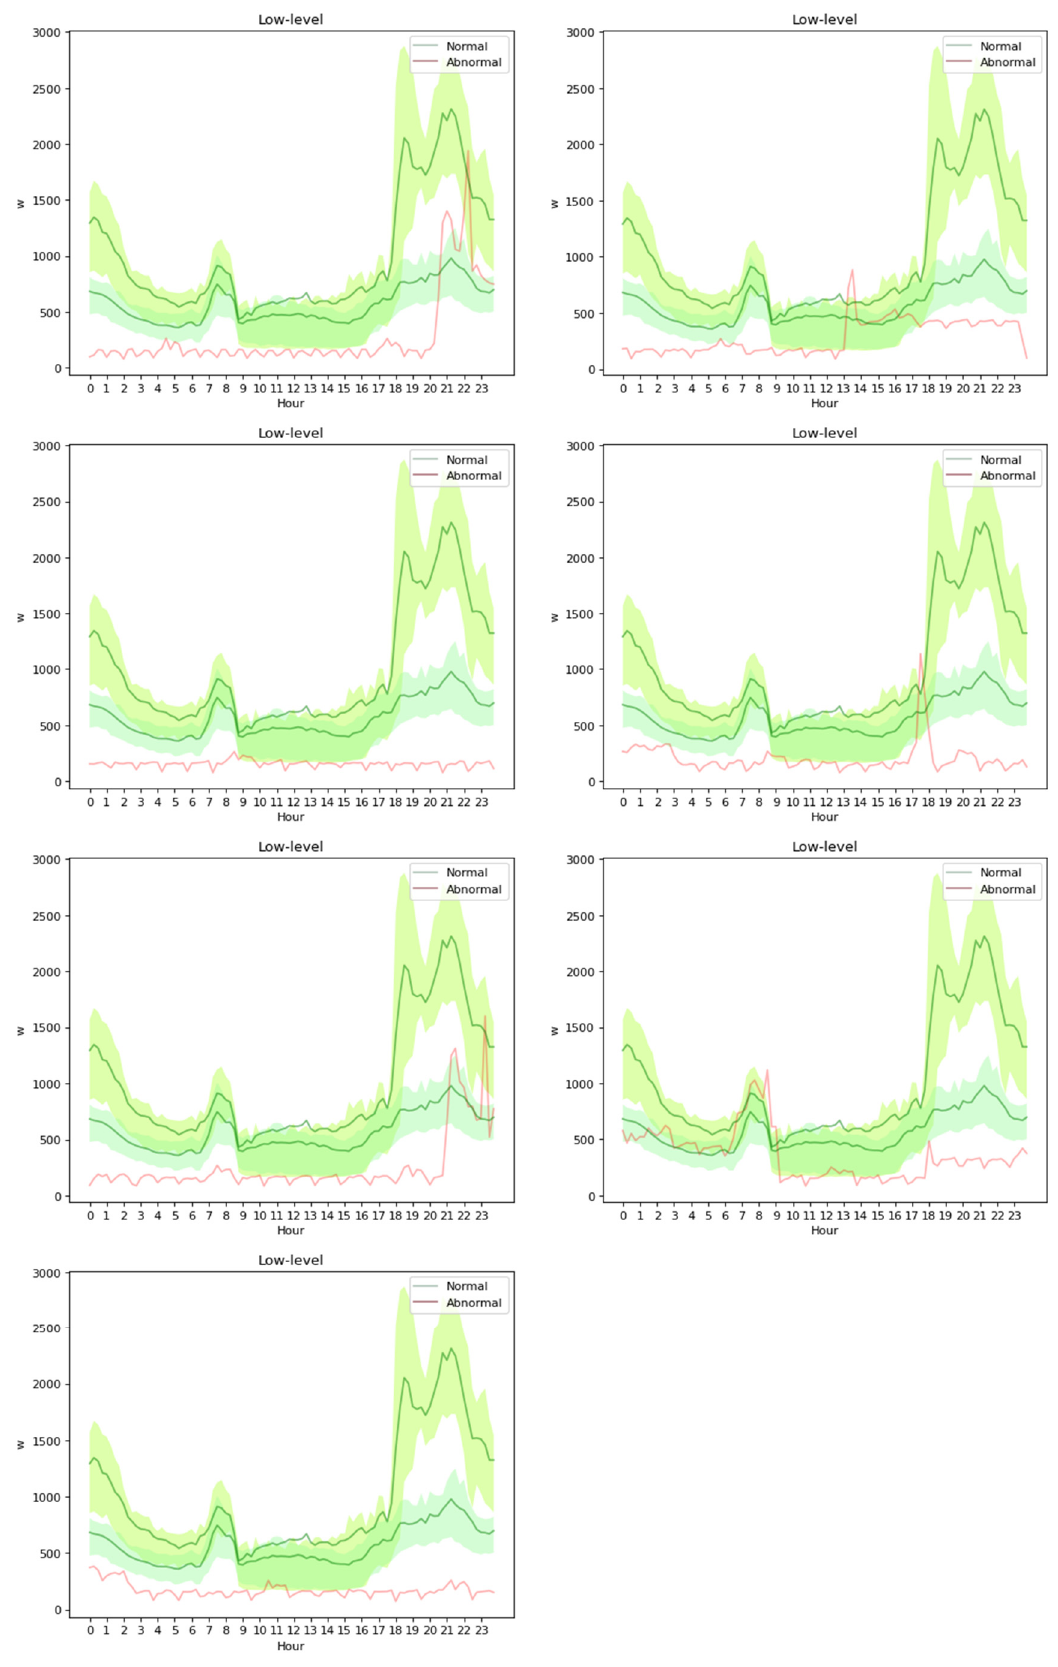
Figure A7. Load profiles of each abnormal electricity consumption events of User 04 using the low- level features.